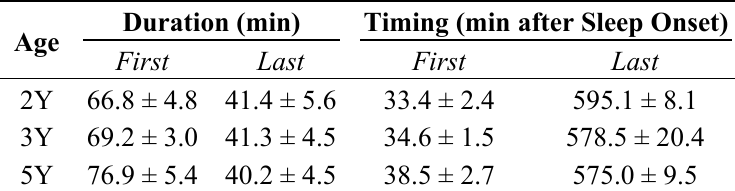
Table 1. Average duration (min) and timing [midpoint of non-REM sleep episode relative to sleep onset, i.e. , first occurrence of sleep stage 2] of first and last non-REM sleep episodes included for comparison (mean ± SEM). Six to ten non-REM sleep episodes were completed across the whole sample, with an average of 8.6 ± 0.5 episodes at 2Y, 8.1 ± 0.4 at 3Y and 7.5 ± 0.3 at